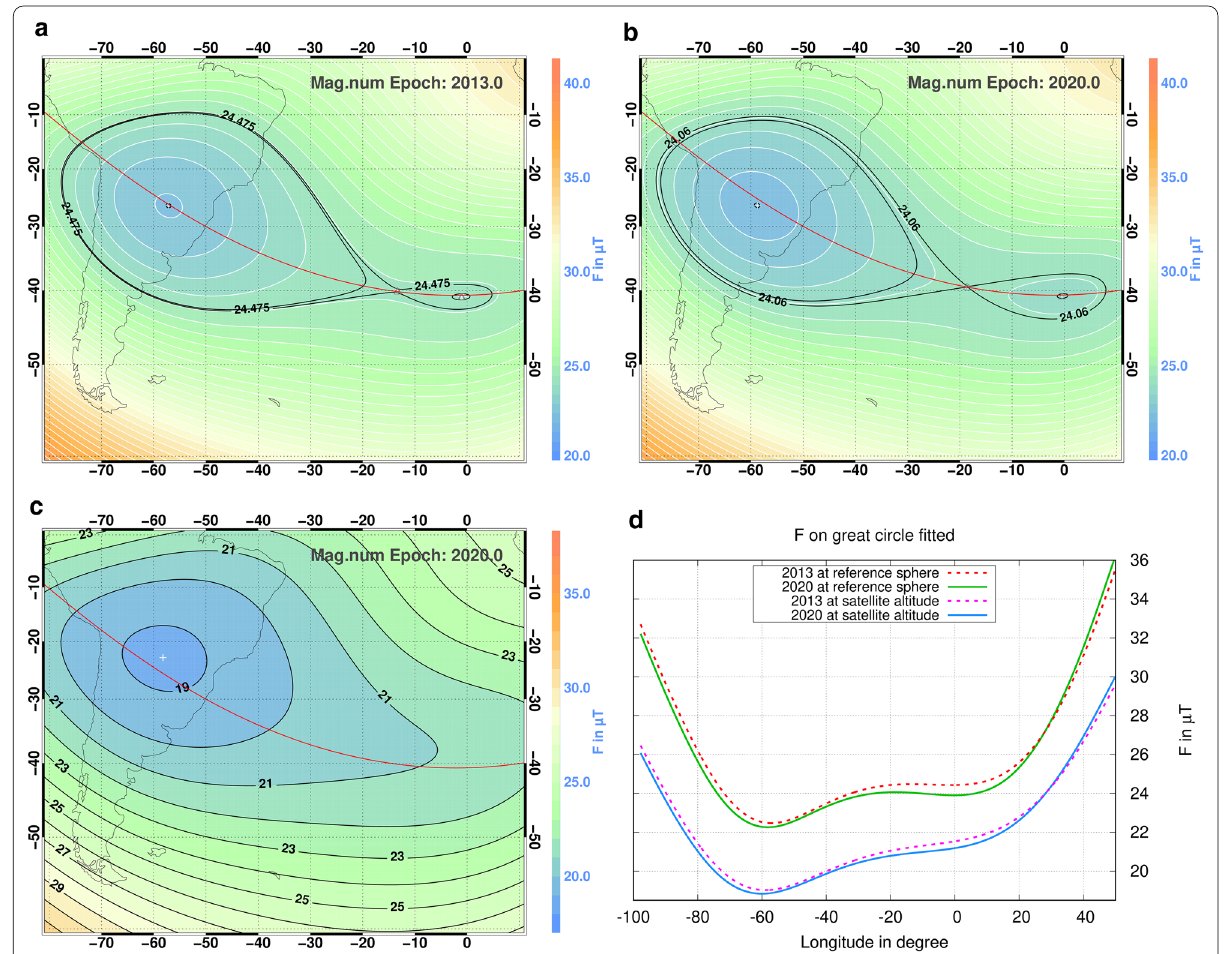
Fig. 7 Magnetic field intensity in the South Atlantic and South America with the two minima of the SAA (symbols) and the contour line going through the saddle point between them (black line) at Earth’s surface for a 2013.0 and b 2020.0 from the Mag.num model. White contour lines are given at every 0.5 µ T . The same is shown for a satellite altitude of 450 km in ( c ) with regular black contour lines every µ T. The red line is the time average great circle fitted to the set of minima and saddle points from 2013.0 to 2020.0. Profiles of field intensity along this great circle are shown for Earth’s surface and satellite altitude from 2013.0 to 2020.0 in ( d